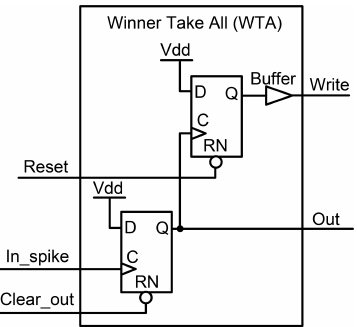
Figure 19. The schematic of the winner-take-all (WTA). It is used to determine the winner among the ASRC